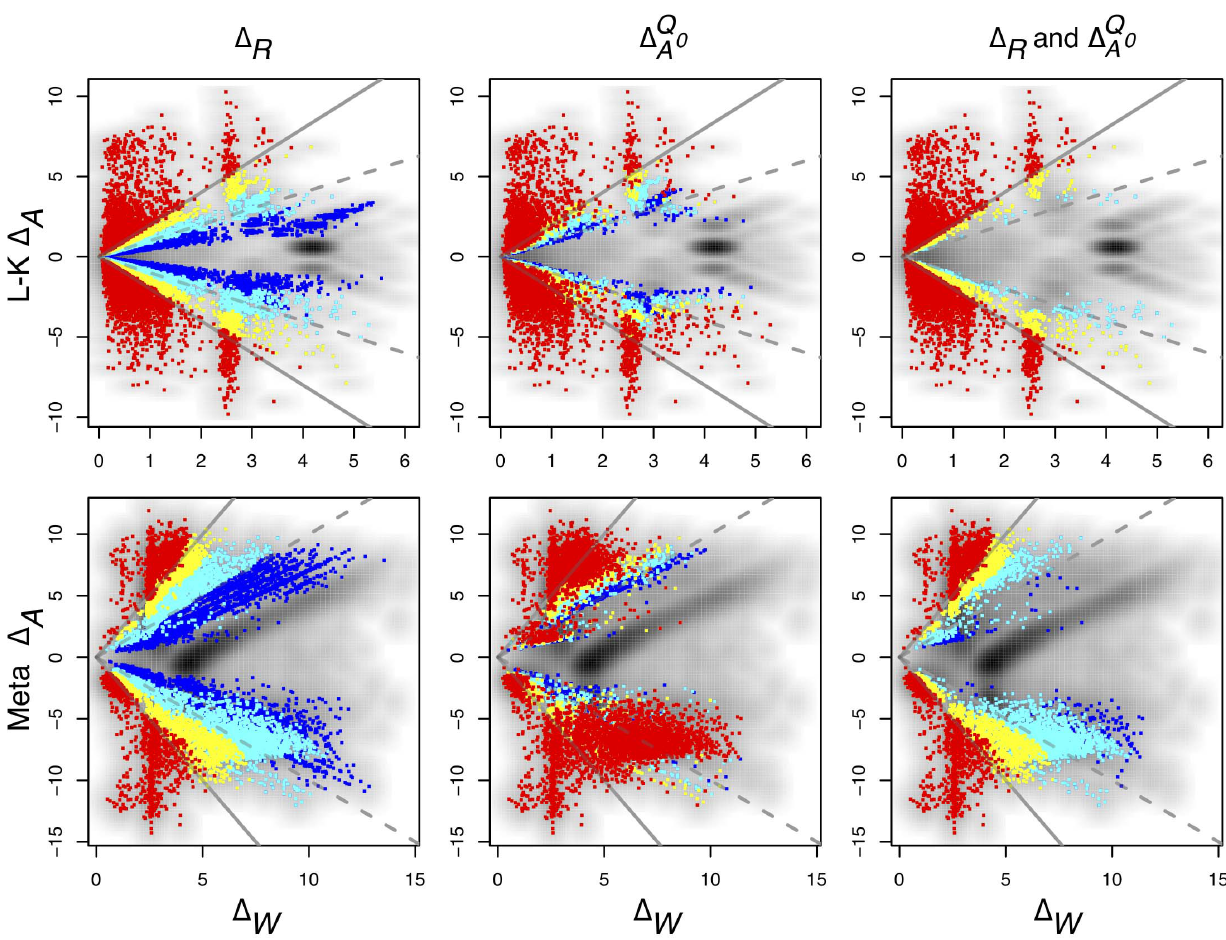
Figure 4. Fold-change to variance (MW) plots of different ALDEx cutoff values. Plotted here are D A (i.e., the log 2 -fold expression changes) vs. D W (i.e., the maximum within-condition expression differences) for the L-K and Meta-RNA-Seq datasets. The grey background shows the density plot of the values. By construction, threshold D R values of + 2 : 0 should select genes for which the between-condition variation is reasonably likely to be at least twice the within-condition variation. This threshold is illustrated by the solid grey line, and the within/between-condition equivalence line cutoffs is shown. Large j D R j values identify genes with a larger between- is shown as the dashed grey line. The effect of altering the D R and D Q 0 A condition differential expression than within-condition variation. The D R values were + 0 : 5 (blue), + 1 : 0 (cyan), + 1 : 5 (yellow) and + 2 (red). There are a number of points where the D R values exceed the chosen threshold in both the L-K and Meta datasets. The D A column shows the effect of . These are plotted for values of 0.1, 0.05, 0.01 and 0.001 in the two datasets, again identifying genes based on the estimated proportion of D Q 0 A coloured as blue, cyan, yellow or red respectively. Here we observed that the 0.01 and 0.001 cutoffs were very similar and the larger cutoffs admitted ƒ 0 : 01 along with each of the D many more genes with high within-condition variation. The third panel shows the effect of enforcing the D Q 0 R cutoff A ƒ 0 : 01 is sufficient to ensure that genes identified as differentially expressed values. In this case we observe that a j D R j § 1 : 5 combined with an D Q 0 A always have lower D W than D A values in both datasets. Using both values in combination allows arbitrarily small fold expression differences to be identified if they are supported by high within-condition